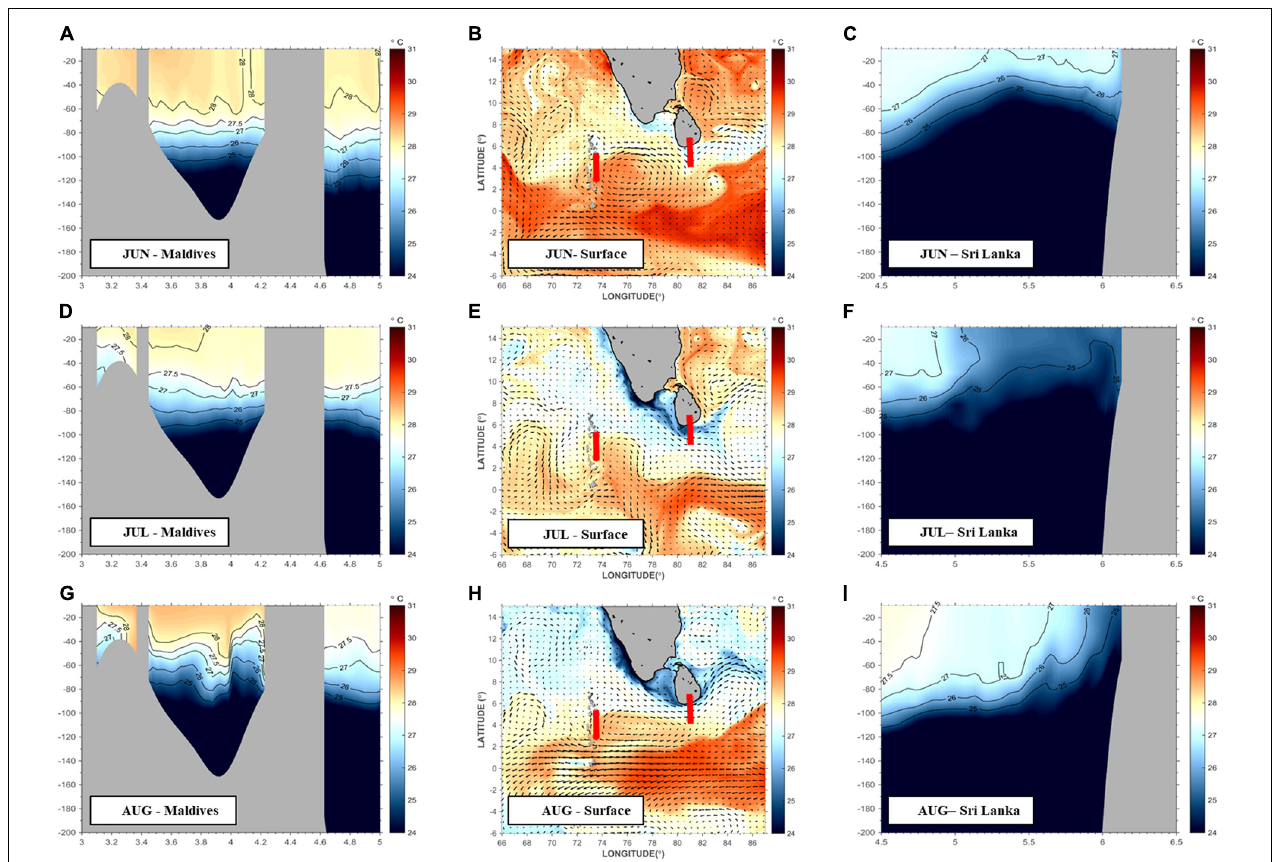
FIGURE 11 | Top to bottom: SWM model output for June, July, and August. Left panel shows the longitudinal temperature transect for Maldives along 74 ◦ E and the right panel shows the longitudinal temperature transect for Sri Lanka along 81 ◦ E. Surface circulation and temperature for the model domain is shown in the middle panel and red lines indicate transect locations. Intra-seasonal temperature variability during the SWM for Maldives and Sri Lanka during (A–C) June, (D–F) July, (G–I) August. Longitudinal temperature transects for Maldives along 73 ◦ E are shown in (A) June (D) July (G) August. Surface circulation and temperature for the model domain is shown in (B) June (E) July (H) August. Longitudinal temperature transects for Sri Lanka along 81 ◦ E are shown in the right panel for (C) June (F) July (I)